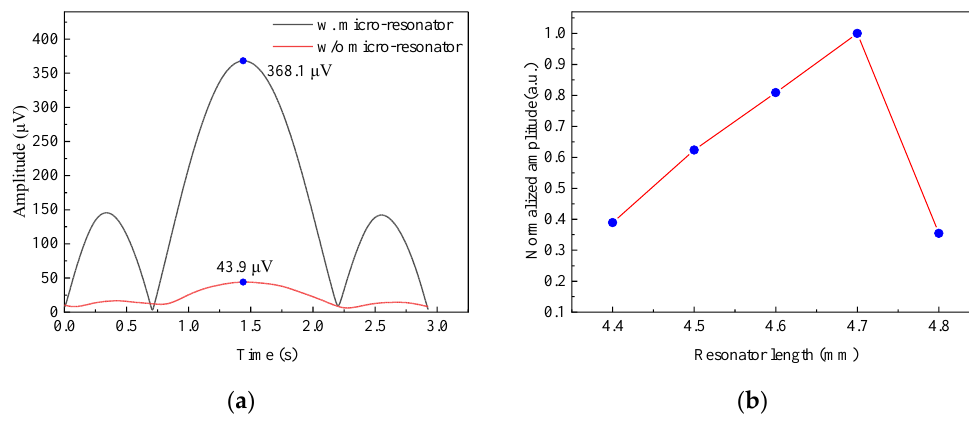
Figure 3. (a) The QEPAS signals with and without the micro-resonator . (b) The QEPAS signals with micro-resonator tubes at different lengths.